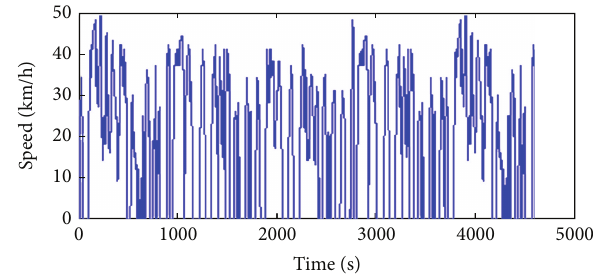
Figure 6: The predicted road condition.